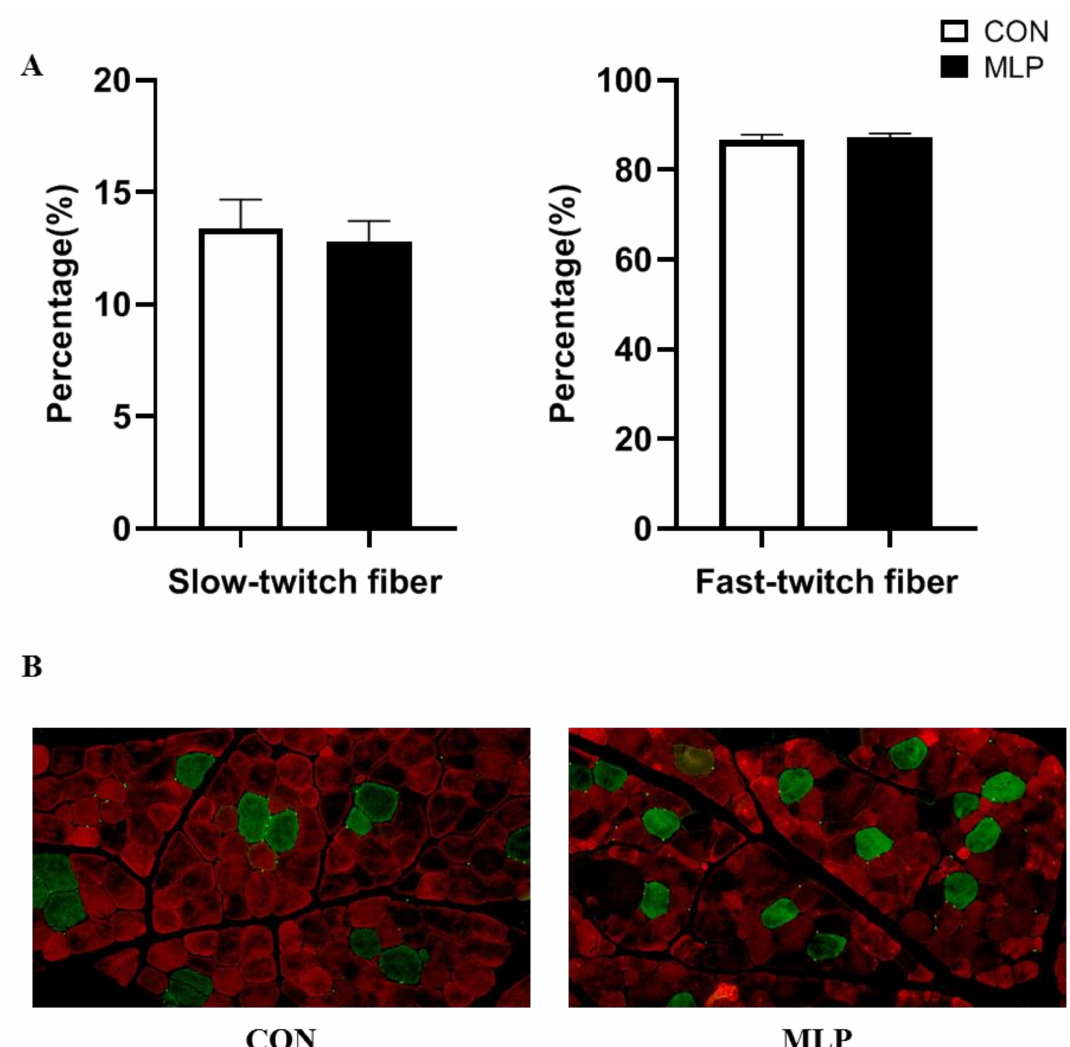
Figure 3. Effect of dietary supplementation with mulberry leaf powder (MLP) on muscle fiber type conversion in longissimus thoracis (LT) muscle of Tibetan pigs. ( A ) Immunofluorescence analyzed the percentage of fast-twitch (red) and slow-twitch (green) fibers in the longissimus thoracis (LT) muscle of Tibetan pigs. ( B ) Representative images showing fiber types in LT muscle. Data are expressed as means ± SEM. N =